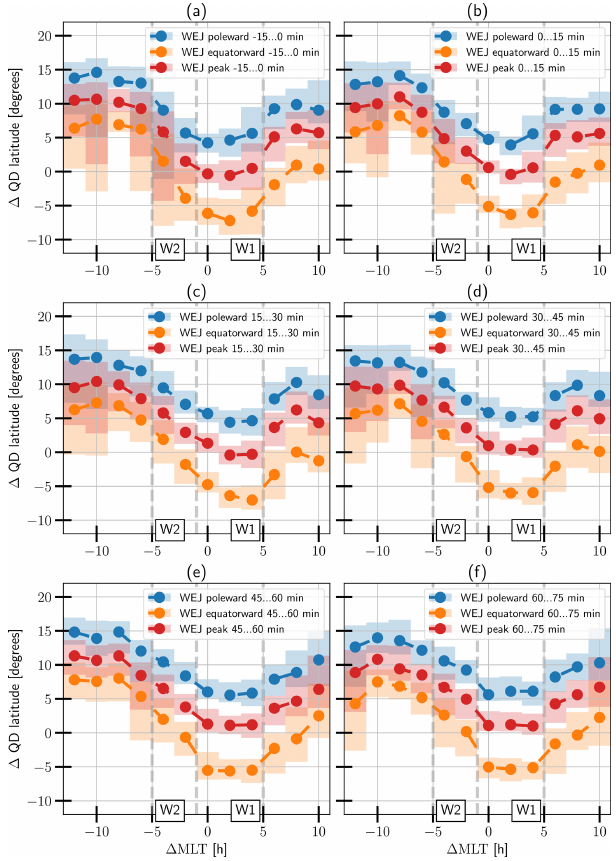
Figure 8. The evolution of the EEJ maxima location and extent for the time period from 15min before to 75min after the onset. (cid:49) QD is the latitude relative to the onset latitude. The lines show the me- dian, and the shading shows the range covered by the second and third